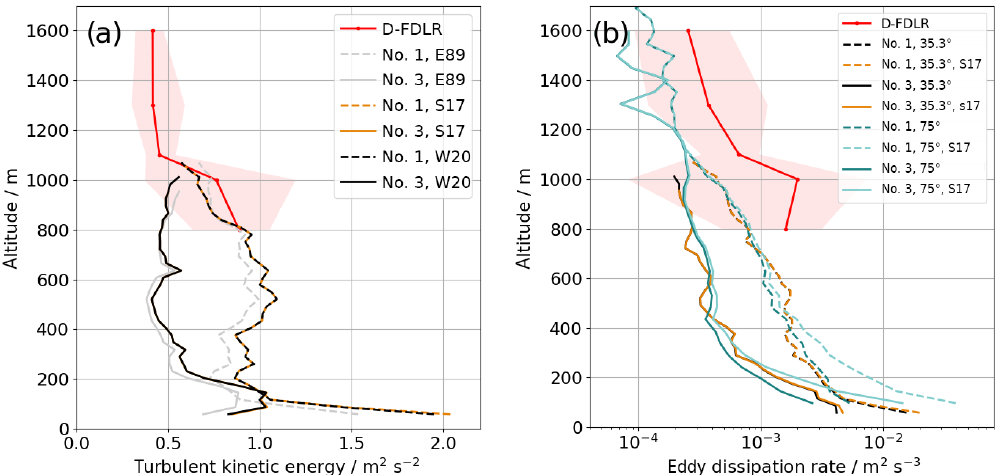
Figure 12. Vertical profile of TKE (a) and ε (b) compared to measurements by D-FDLR.